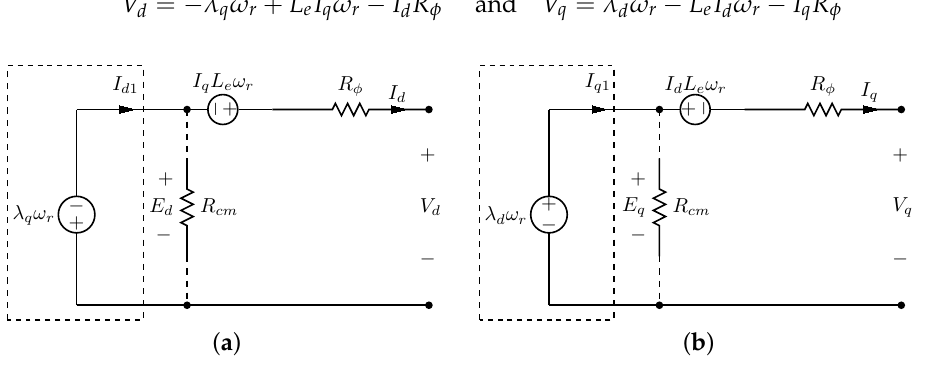
Figure 8. Rotor reference frame equivalent circuits: ( a ) d -axis and ( b ) q